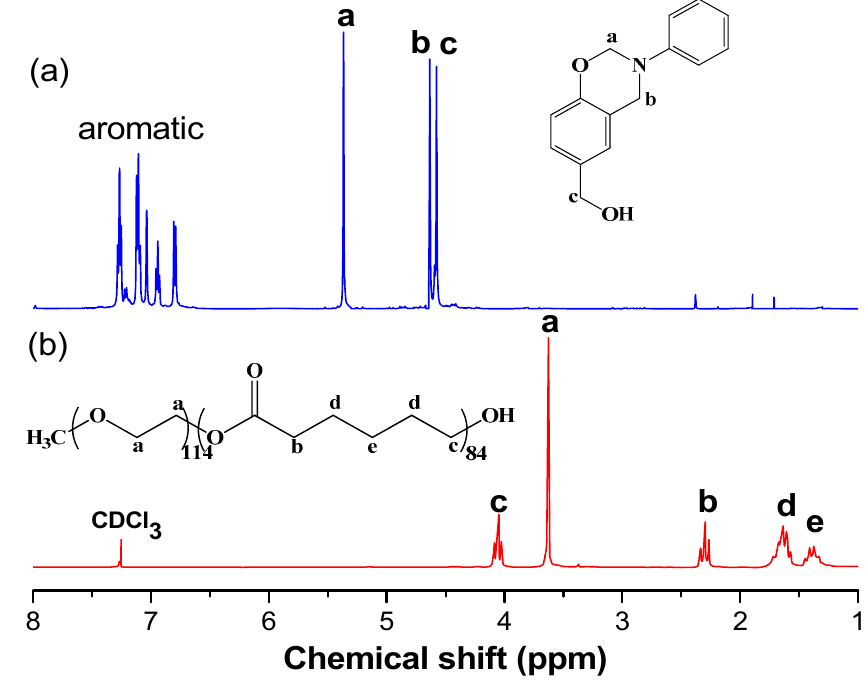
Figure 3. 1 H NMR spectra of ( a ) PA ‐ OH and ( b ) PEO ‐ b ‐ PCL.